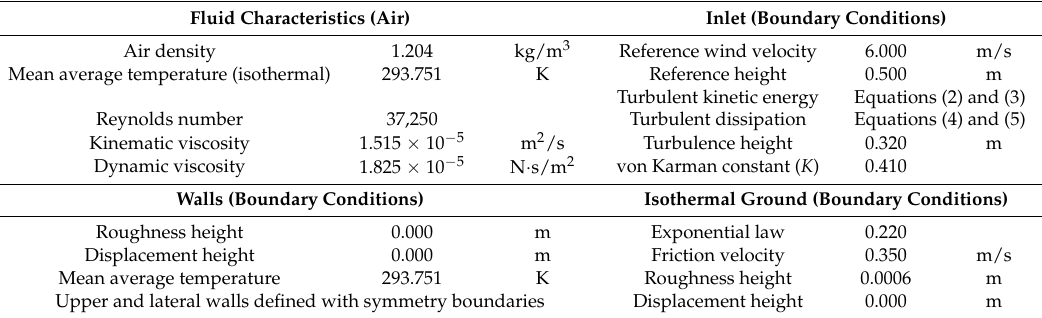
Table 2. Boundary conditions and aero-dynamical parameters applied in the numerical model.